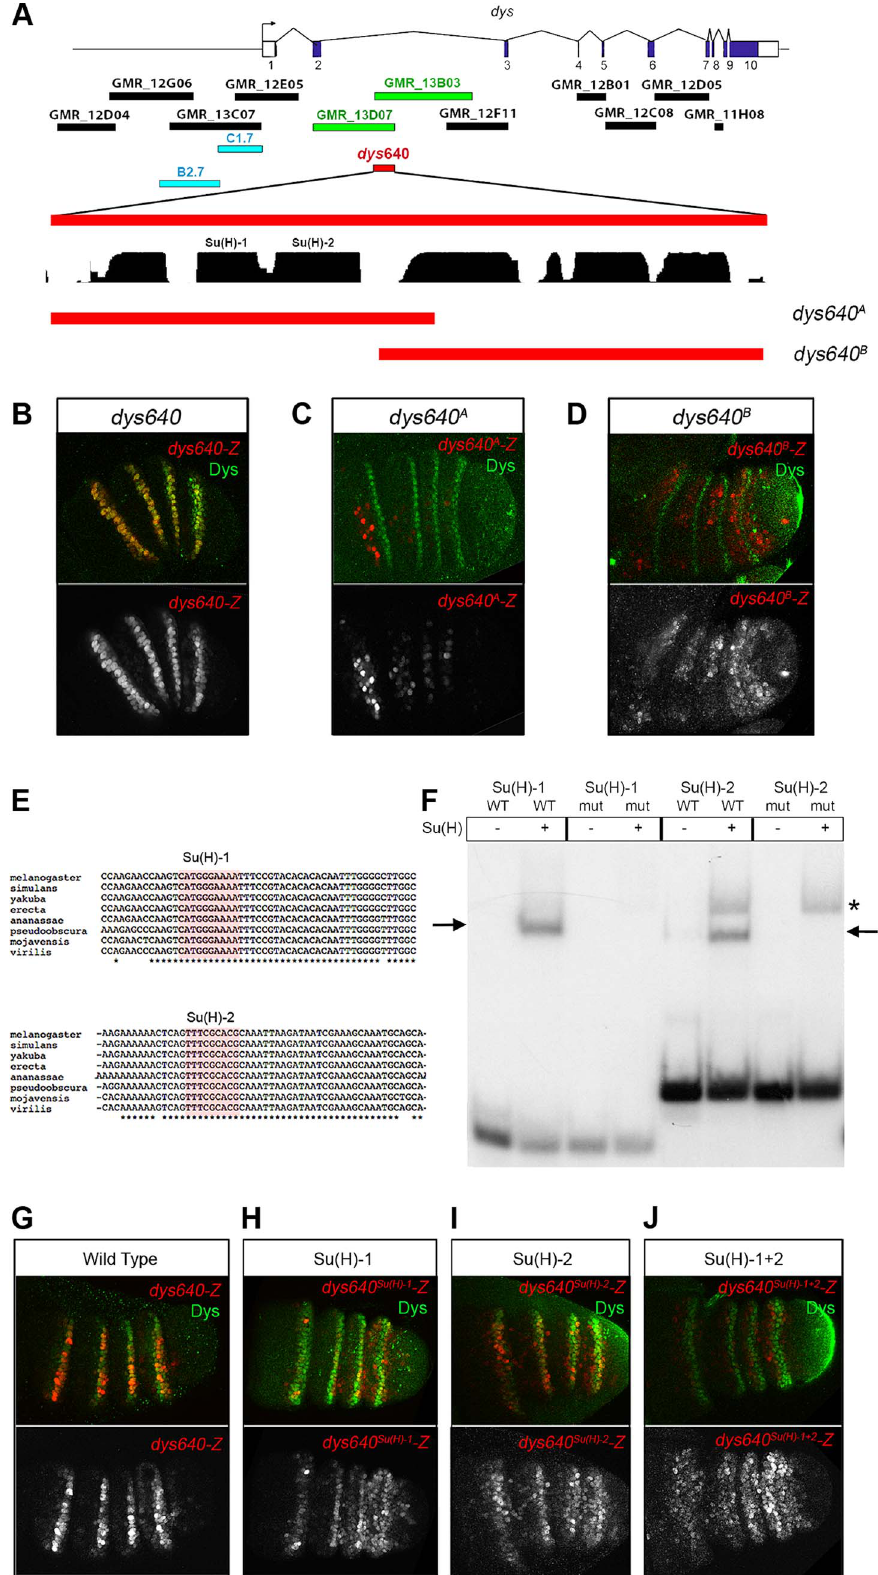
Figure 7. dys is a direct target of the Notch pathway. (A) Schematic representation of dys cis -regulatory region. Horizontal bars represent the DNA elements available in the Janelia database that maps around and within the dys gene. Blue bars correspond to the dys -CRMs identified by Jiang et al., 2010 [40] that drove reporter gene expression in fusion tracheal cells. Two Janelia lines (GMR_13D07 and GMR_13B03, green bars) drove